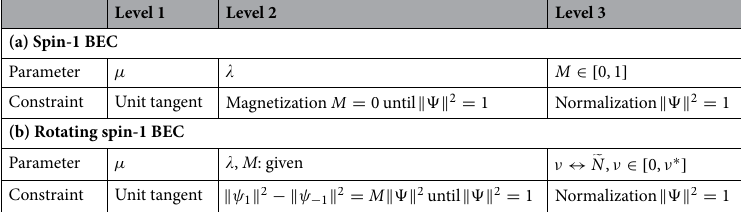
Table 1. Comparison of the parameters and the associated constraints between the algorithms for spin-1 BEC and rotating spin-1